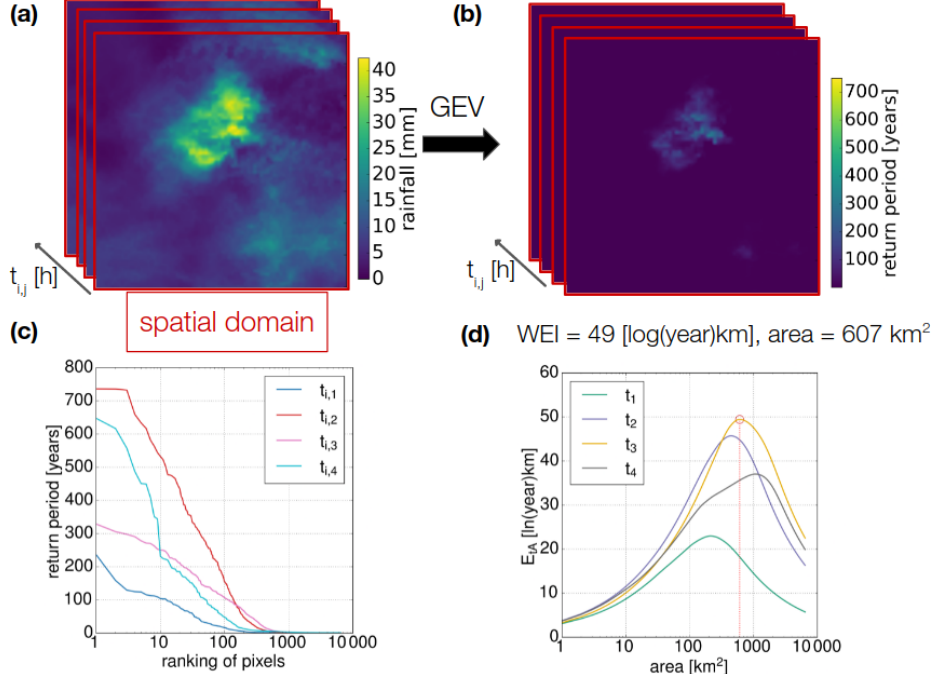
Figure 1. Explanation of the WEI. (a) Rasters with rainfall intensities at duration t i for a spatial domain (red) that captures an HPE for each hour ( t i, 1 – t i, 4 ) of the event. (b) For each pixel and for each time step ( j = 1 , ..., 4), the return period is calculated. (c) The pixels are sorted by return period in descending order. (d) For each group of ranked pixels, E tA is calculated. The steps in (b) to (d) are repeated for all durations t i . In this exemplary case with four time steps and four durations ( i = 1 , ..., 4), this results in 16 E tA curves. Panel (d) shows only the E tA curve with the highest maxima for each duration t 1 , ..., 4 . The maximum of all the resulting curves is the WEI (49 [ln(year)km], encircled in red). The maximum was achieved at t 3 at a spatial extent of 607km 2